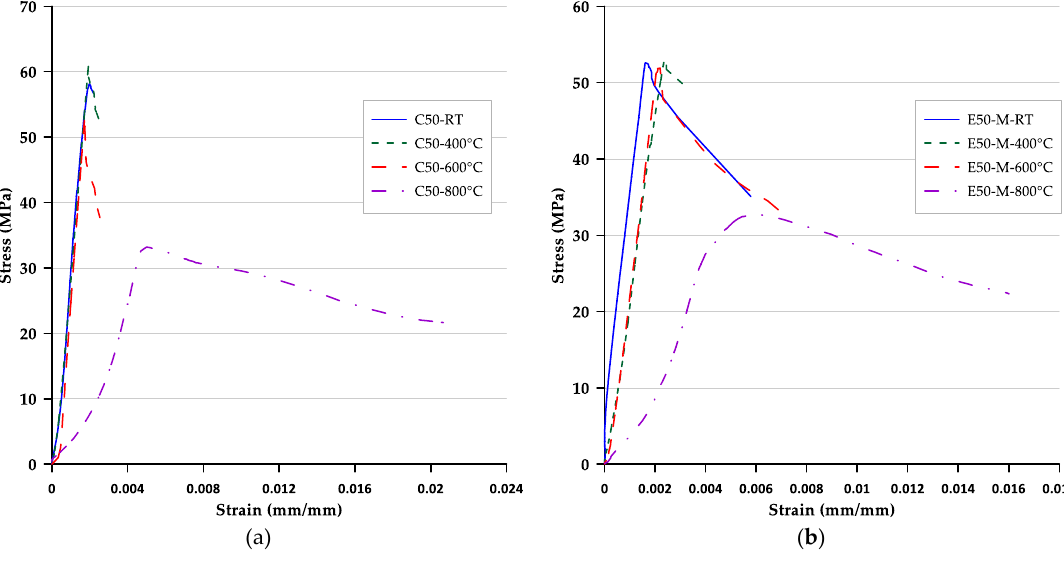
Figure 7. Stress versus strain curves of medium-strength LWC specimens: ( a ) control group C50 and ( b ) experimental group E50-M.